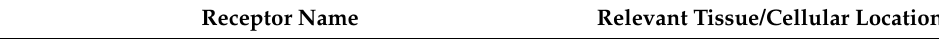
Table 1. Bile acid